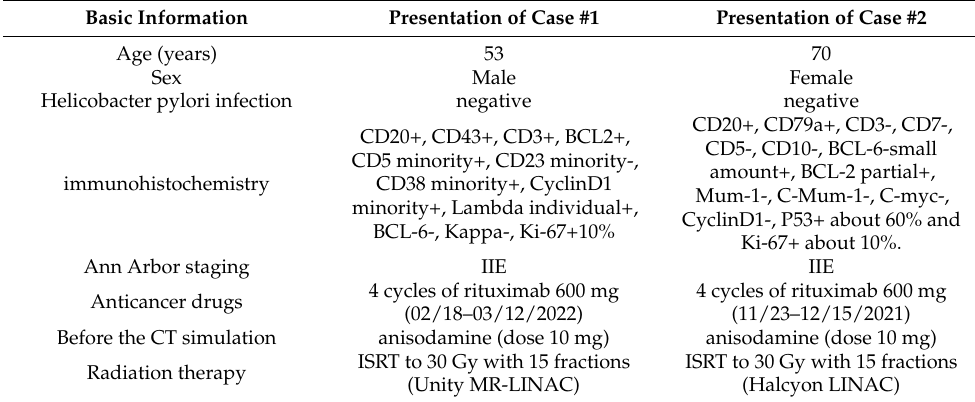
Table 2. Comparison of the two patients’